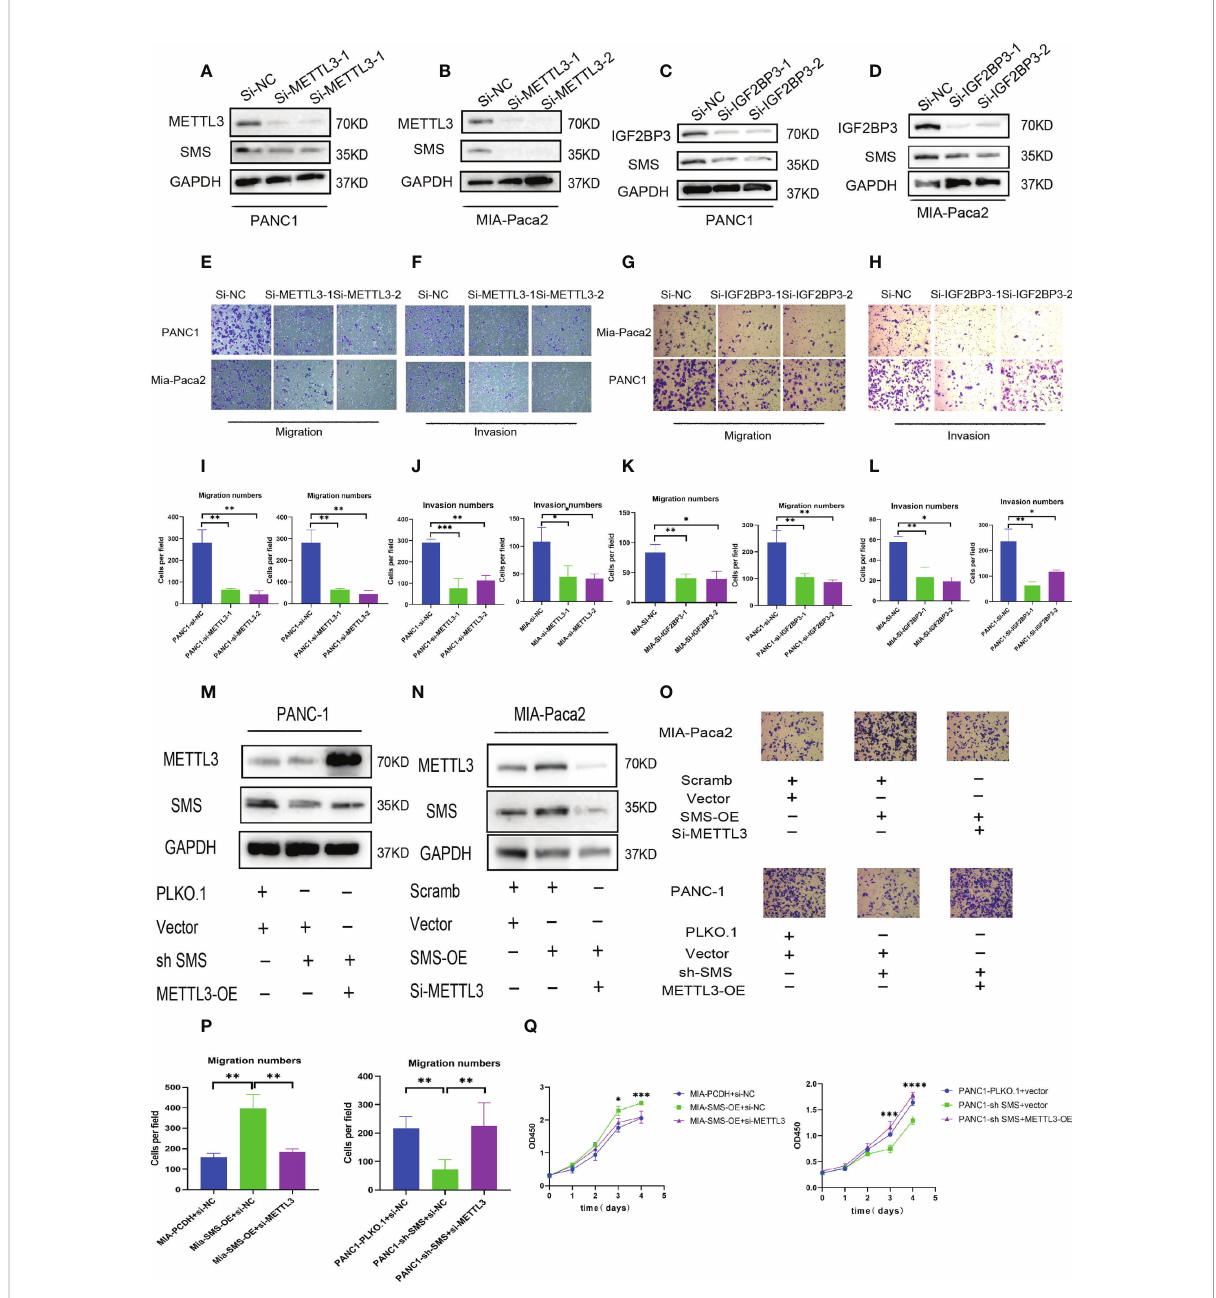
FIGURE 5 METTL3 and IGF2BP3 regulate SMS expression and promote pancreatic cancer metastasis. (A-D) The expression level of SMS interferes with the expression of METTL3 and IGF2BP3 in Mia-Paca2 and PANC1 cells. (E-L) Transwell assays of SMS interferes with the expression of METTL3 and IGF2BP3 in Mia-Paca2 and PANC1 cells were performed. Representative images and quantifcation of the results are presented. (M, N) METTL3 reversed the expression of SMS in stable SMS overexpression/knockdown PDAC cell. (O, P) Transwell experiments found that METTL3 could reverse the migration ability of stable SMS overexpression/knockdown PDAC cell. (Q) CCK-8 experiments found that METTL3 could reverse the proliferation of stable SMS overexpression/knockdown PDAC cell. *P < 0.05; **P < 0.01; ***P < 0.001; ****P <